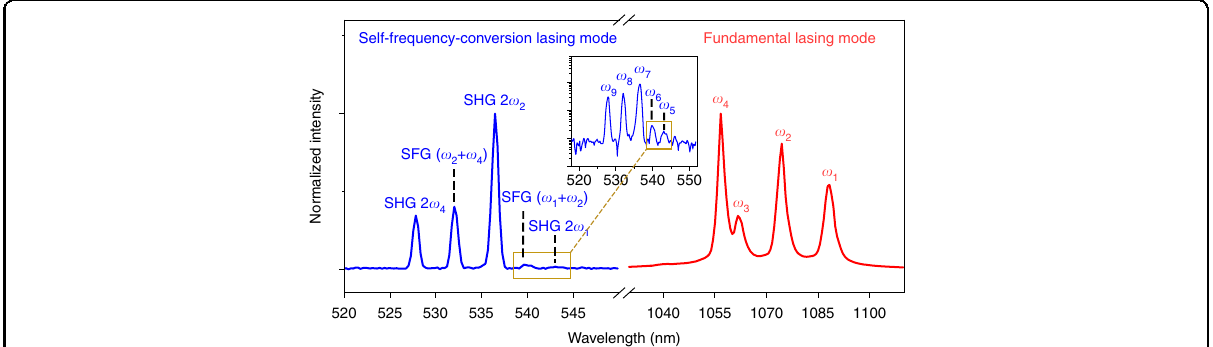
Fig. 5 Multiple self-frequency-conversion wavelength output of a multimode NW laser due to second-order nonlinear effect. Normalized fundamental lasing modes (red line) and self-frequency-conversion modes (blue line), including SHG and SFG. Inset shows self-frequency-conversion signals plotted on logarithmic